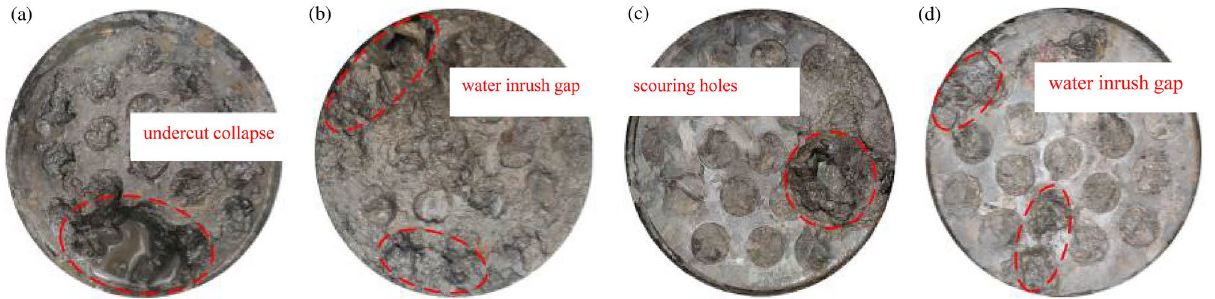
Figure 11. Pore channel conditions of each grade of sample after infiltration.